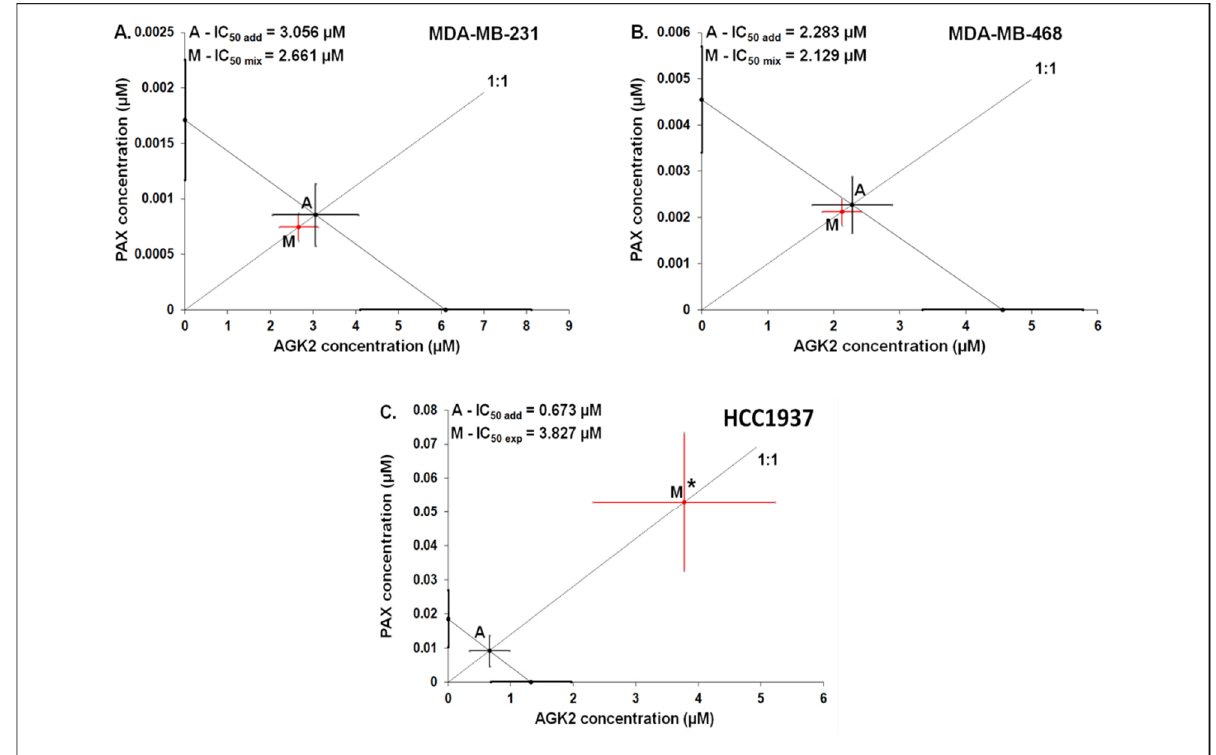
Figure 13. Isobolographic analysis between PAX and AGK2 for collateral CECs. Isobolograms illustrate additive and antagonistic interactions between PAX and AGK2 with respect to their antiproliferative effects in the MDA-MB-231 ( A ), MDA-MB-468 ( B ) and HCC1937 ( C ) cells. The IC 50 values for PAX and AGK2 are plotted graphically on the X- and Y-axes, respectively. The solid lines on the X- and Y-axes represent the SEM for the IC 50 values for the studied drugs administered alone. The diagonal line connecting the IC 50 values for PAX and AGK2 illustrates the isobole of additivity. The line starting from the beginning of the Cartesian plot system corresponds to the constant ratio of 1:1 for the combination of the drugs. Point A depicts the theoretically calculated IC 50 add value for the isobole of additivity. Point M represents the IC 50 mix value for the total concentration of the mixture expressed as proportions of PAX and AGK2 that produced a 50% antiproliferative effect (50% isobole). On the graph, the SEM values are presented as horizontal and vertical error bars for every IC 50 value. The IC 50 mix value for the BC cell line HCC1937 is placed significantly above point A, indicating a sub-additive (antagonistic) interaction (Student’s t -test with Welch’s correction; * p < 0.05) between PAX and AGK2. In contrast, the IC 50 mix values for the BC cell lines MDA-MB-231 and MDA-MB-468 are placed close to point A, indicating an additive interaction between PAX and AGK2 in the MDA-MB-231 and MDA-MB-468 BC cells.